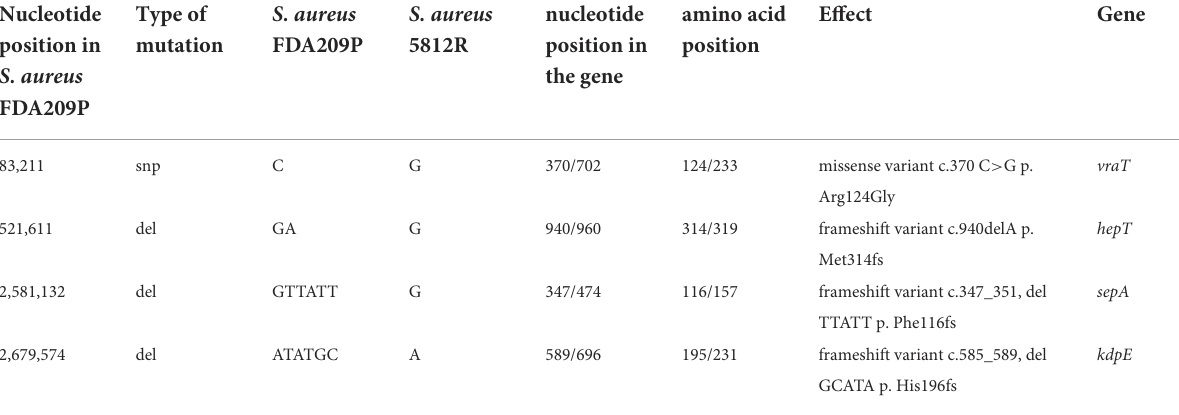
TABLE 4 Genetical differences between the wild-type S. aureus FDA209P and its mutant variant S. aureus 5812R.